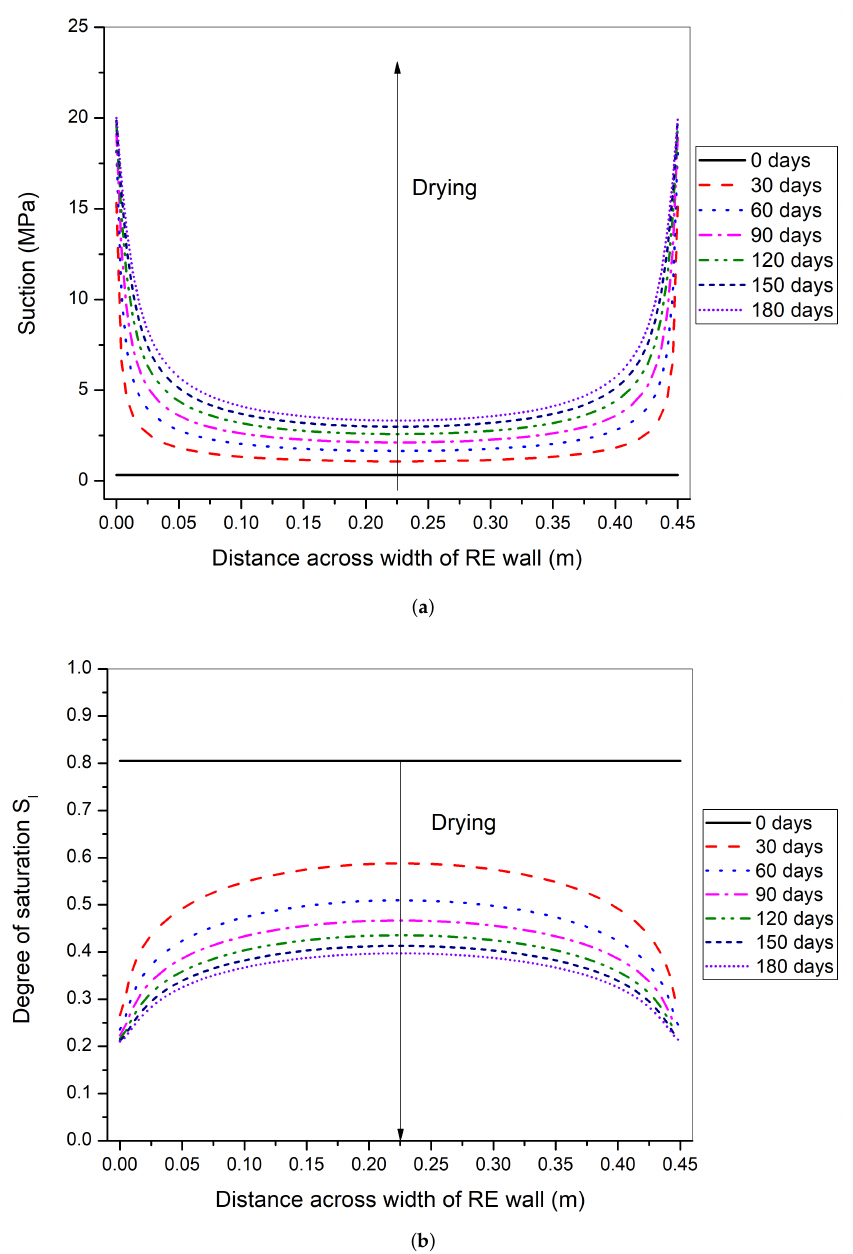
Figure 15. Suction ( a ) and degree of saturation ( b ) variation across the width of rammed earth wall at 0, 30, 60, 90, 120, 150, and 180 days of drying period in winter-like environmental conditions.